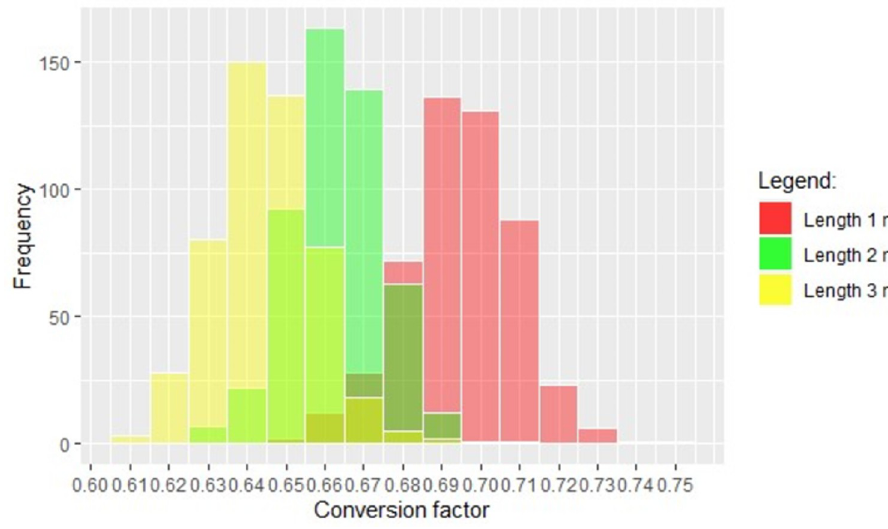
Fig 8. Distribution of the resulted conversion